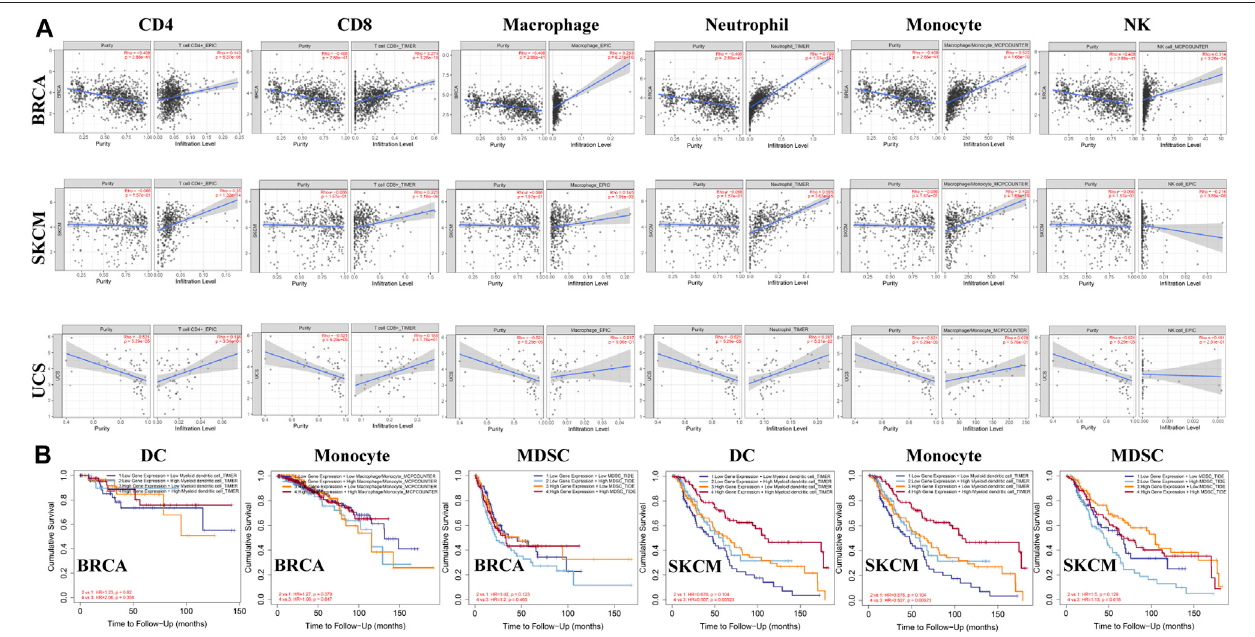
FIGURE 7 | Analysis of immune in fi ltration of ACSL4 in different cancers from the TIMER database. (A) . ACSL4 expression has signi fi cantly negatively correlated with tumor purity and signi fi cantly positively correlated with the in fi ltration levels of CD4+T cell, CD8+T cell, macrophage, neutrophil, monocyte and NK in BRCA (breast invasive carcinoma). ACSL4 expression has no relation with tumor purity and signi fi cantly negatively correlated with NK, and signi fi cantly positively correlated with the in fi ltration levels of CD4+T cell, CD8+T cell, macrophage, neutrophil, monocyte and in SKCM (skin cutaneous melanoma). ACSL4 expression has signi fi cantly negatively correlated with tumor purity and NK, and no relation with in fi ltrating levels of CD4+T cell, CD8+T cell, macrophage, neutrophil, monocyte in UCS (uterine carcinosarcoma). p < 0.05 is considered as signi fi cant. (B) . Correlation between ACSL4 mRNA expression, with in fi ltrating levels of DC, monocyte, MDSC (Myeloid derived suppressor cell) and prognosis in BRCA (breast invasive carcinoma) and SKCM (skin cutaneous